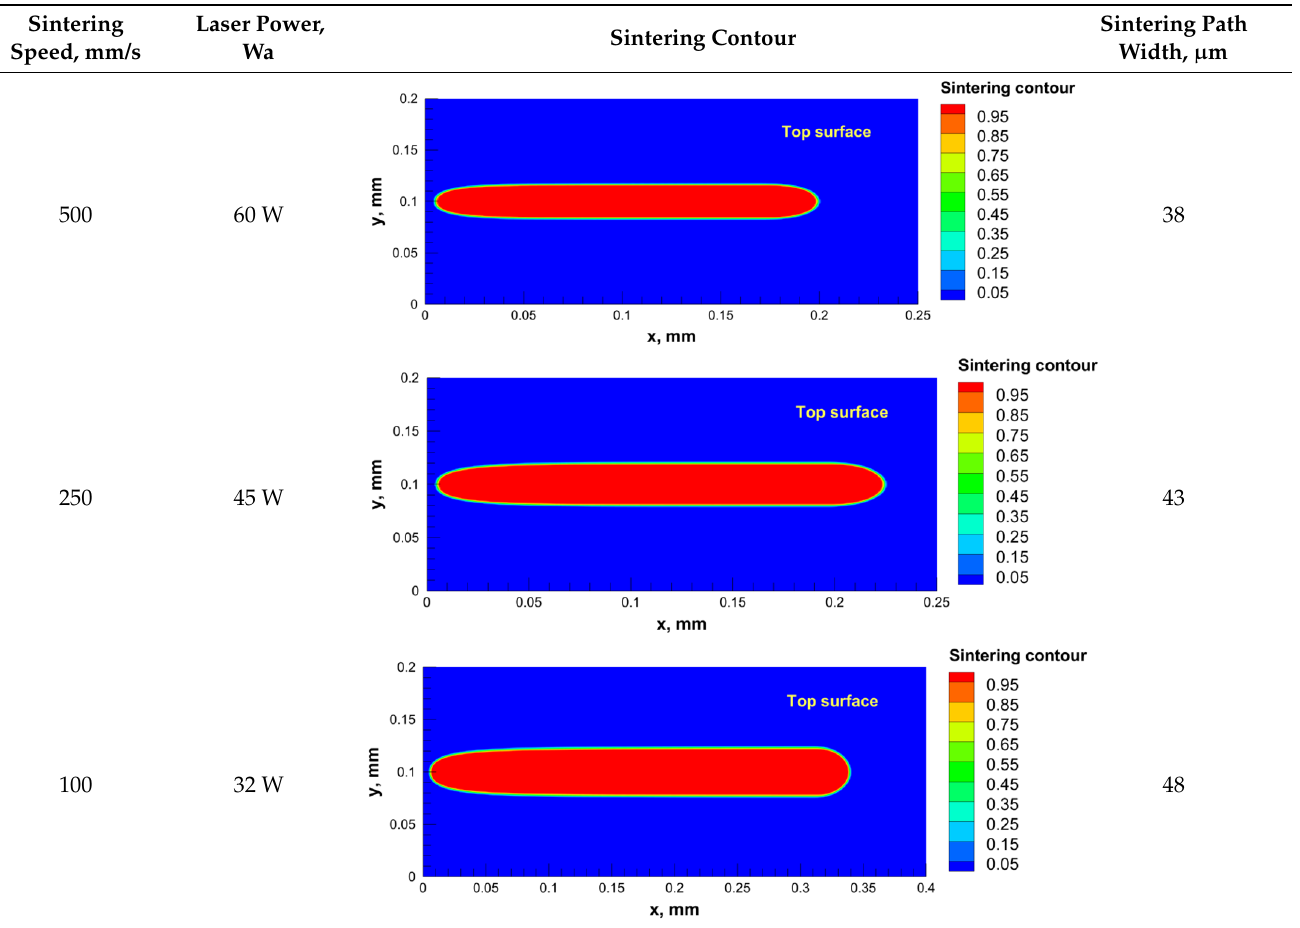
Table 5. The width of the scanning path for each sintering speed with the laser power.